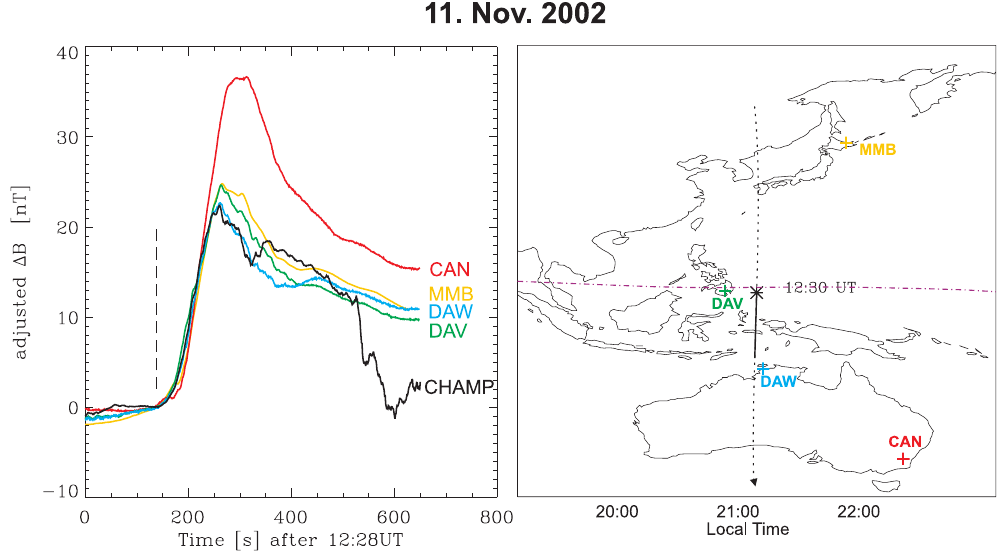
Fig. 2. The SC event of 11 November 2002 recorded by CHAMP (black) and at four ground stations (coloured) in the western Pacific region. The CHAMP trajectory and the locations of the ground stations are indicated on the map at the right hand side. The asterisk on the CHAMP track marks the position at the time of the SC onset. The dashed-dotted line reflects the geomagnetic equator.